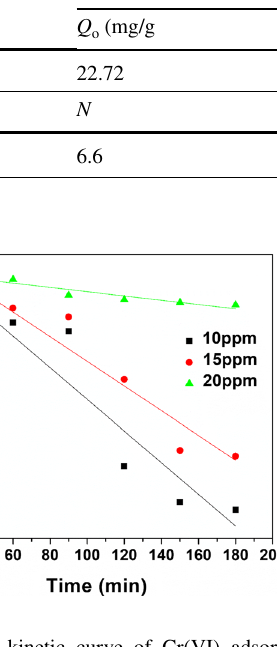
Table 1 Langmuir and Freundlich adsorption isotherm parameters Isotherm models